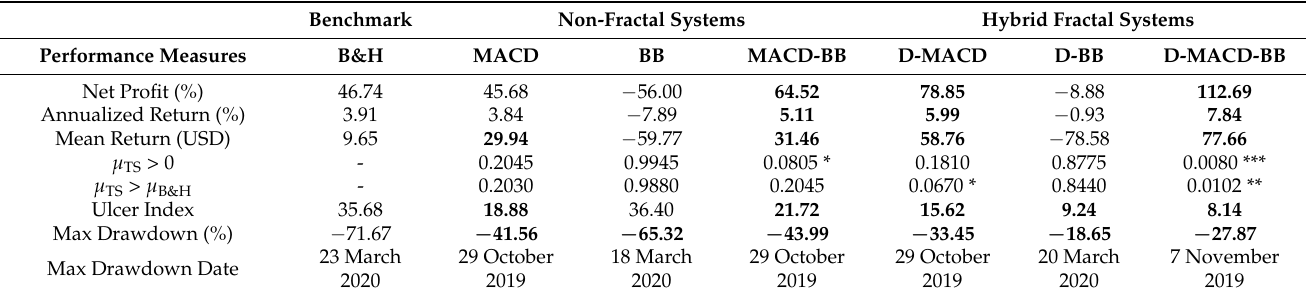
Table 2. Profitability and risk of the technical trading systems and the benchmark.